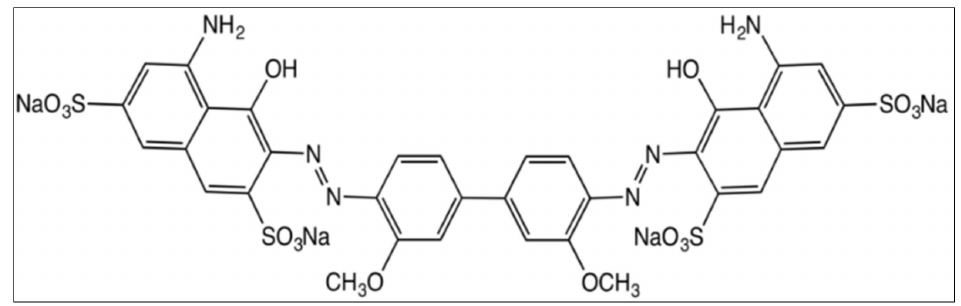
Figure 1. Structure of Direct Blue 15 dye used in the present